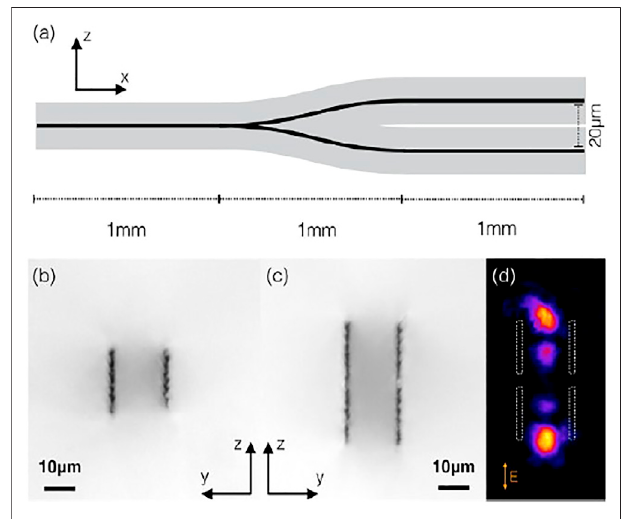
FIGURE 9 | (A) Schematic view of the vertical Y-splitter. Transmission images of the input (B) and output (C) facet of the splitter. (D) An image of the output near- fi eld mode with a 50:50 power splitting